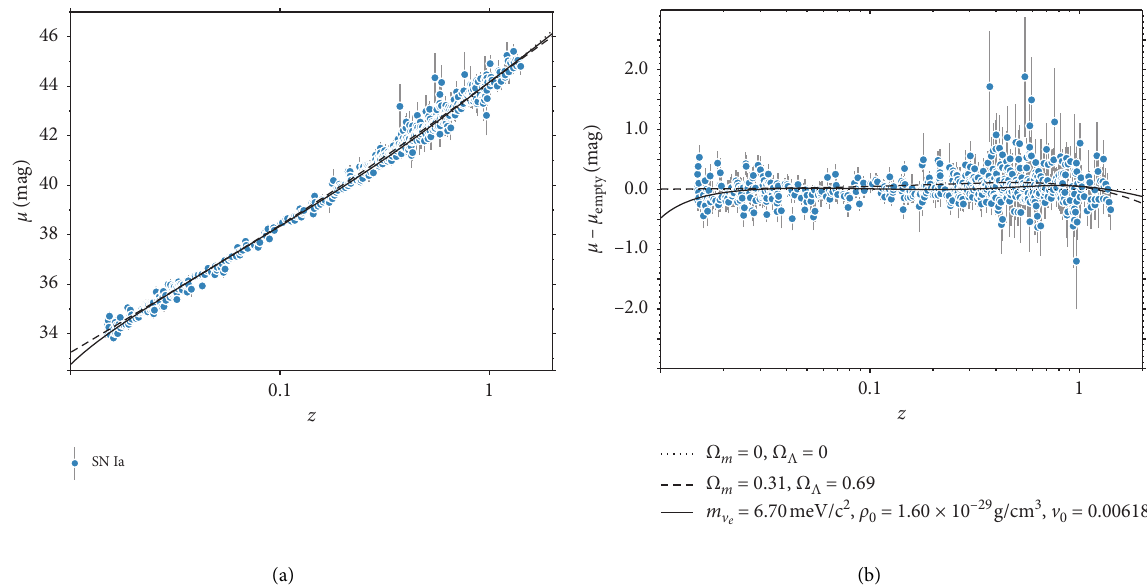
Figure 4: (a) Hubble diagram of 580 SNe Ia (circles) from the Union catalog [48] with comparable fits by the Λ CDM model (dashed line) and the ATLAS model (solid line). (b) Hubble diagram relative to the empty universe model for a better comparison. The difference between the two models at z < 0.04 is created by the assumption of an initial average expansion velocity of galaxies ( v explain the 4.4 σ Hubble tension [25, 26]. Note that the central density ρ 0 is quantitatively comparable to the dark energy density of the Λ CDM model ( ρ Λ ≈ 6 × 10 − 30 g/cm 3